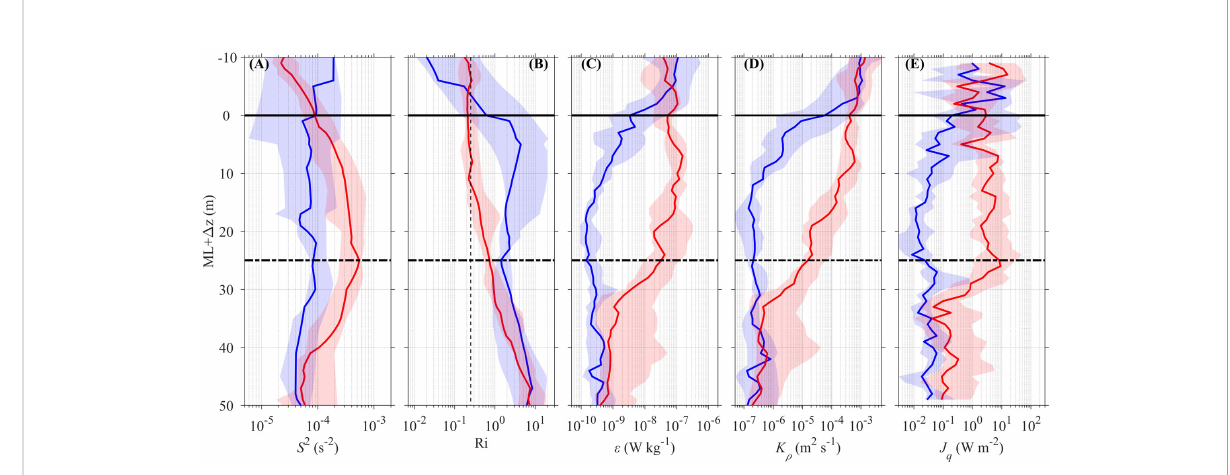
FIGURE 5 Vertical pro fi les of observed (A) shear variance ( S 2 ), (B) Richardson number (Ri; Ri = 0.25 is marked by the vertical dashed black line), (C) TKE dissipation rate ( e ), (D) diapycnal diffusivity ( K r ), and (E) turbulent heat fl ux ( J q ) in the stations with (Stations 5 – 13, red) and without (Stations 1 – 4/ 14 – 16, blue) the presence of deep cycle turbulence. The solid curves are the ensemble median, and the shading area shows the 95% bootstrapped con fi dence interval. The vertical coordinate is of reference moving with the base of the mixed layer (ML). The thick solid and dash-dotted lines indicate the bases of the mixed layer and the deep cycle turbulence layer,